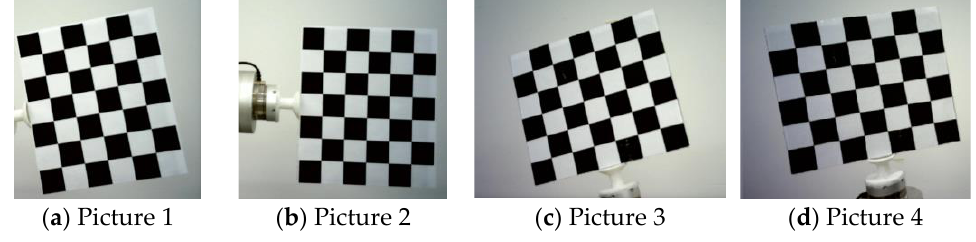
Figure 8. Some pictures captured by the cameras.